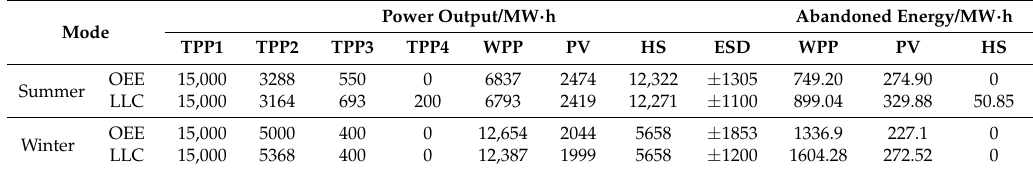
Table 4. The power output results of MECS scheduling on a typical day. ESD: energy storage device; HS: hydropower station.